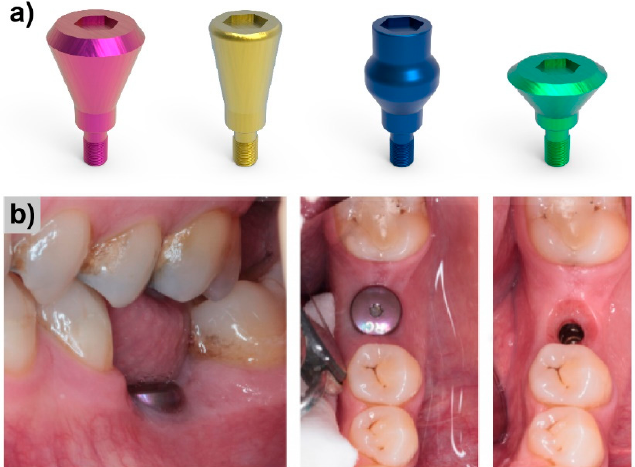
Figure 8. Implant abutments. Examples of ( a ) of various geometries of abutments and ( b ) their placement in the oral cavity. Pictures ( b ) reproduced with permission from Reusing Titanium Healing Abutments , Darin Dichter, 4 April 2016.